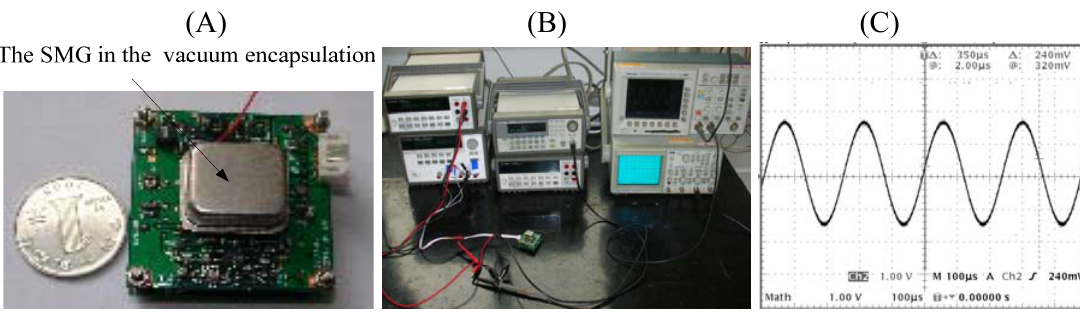
Figure 11. The experiment of closed-loop driving. (A) The PCB circuitry of SMG. (B) The test setup environment. (C)The vibrating waveshape of closed loop driving signal.